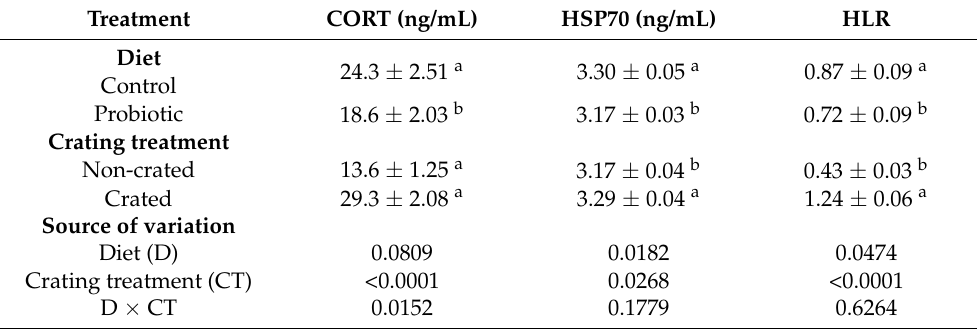
Table 2. Mean ( ± SEM) serum corticosterone (CORT) (ng/mL) and heat shock protein (HSP) 70 (ng/mL) levels, and heterophil to lymphocyte ratios (HLR) by diet and crating treatment in ducks on day 21.